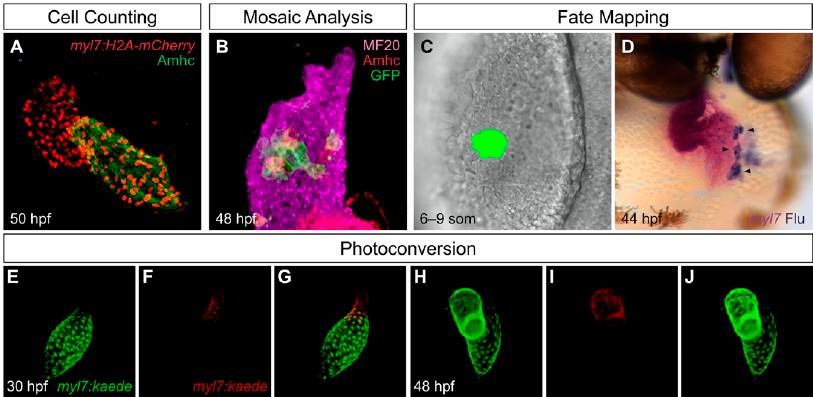
Figure 1. Useful tools for analysis of cardiac chamber development in zebrafish. ( A ) Transgenes such as Tg(myl7:H2A- mCherry) label myocardial nuclei (red) and facilitate counting of the cardiomyocytes in each chamber; the atrial myosin heavy chain Amhc (green) distinguishes the atrium from the ventricle. Lateral view of wild-type heart at 50 h post-fertilization (hpf) is adapted from [27]. ( B ) Mosaic analysis enables assessment of the cell-autonomy of gene function. In this example, adapted from [27], mosaic distribution of the transgene Tg(hsp70:dnfgfr1-eGFP) (green) inhibits FGF signaling in specific ventricular cells, several of which exhibit ectopic Amhc, indicating a cell-autonomous requirement for FGF signaling to repress amhc expression in the ventricle (lateral view). Magenta fluorescence labels sarcomeric myosin heavy chain using the monoclonal antibody MF20, and red fluorescence indicates localization of Amhc, using the monoclonal antibody S46. ( C , D ) Fate mapping follows progenitor cells from their origins to their destinations. In this example, adapted from [28], photoactivation of a caged fluorescein-dextran lineage tracer marks a small group of cells in the anterior lateral plate mesoderm (ALPM) at the 6–9 somite (som) stage ( C , dorsal view). Later, labeled progeny of these cells (arrowheads) are found in the atrium; uncaged fluorescein (blue) is detectable within the myl7 -expressing myocardium (magenta) of the heart ( D , frontal view). ( E – J ) Photoconvertible proteins facilitate tracking of cells over time. In this example, adapted from [29], cardiomyocytes express the transgene Tg(myl7:kaede) , and regionally restricted photoconversion of Kaede at 30 hpf converts its green fluorescence into red fluorescence near the arterial pole of the heart tube ( E – G ). Later, visualization of retained red fluorescence demonstrates that the labeled cells contribute to the ventricle ( H – J